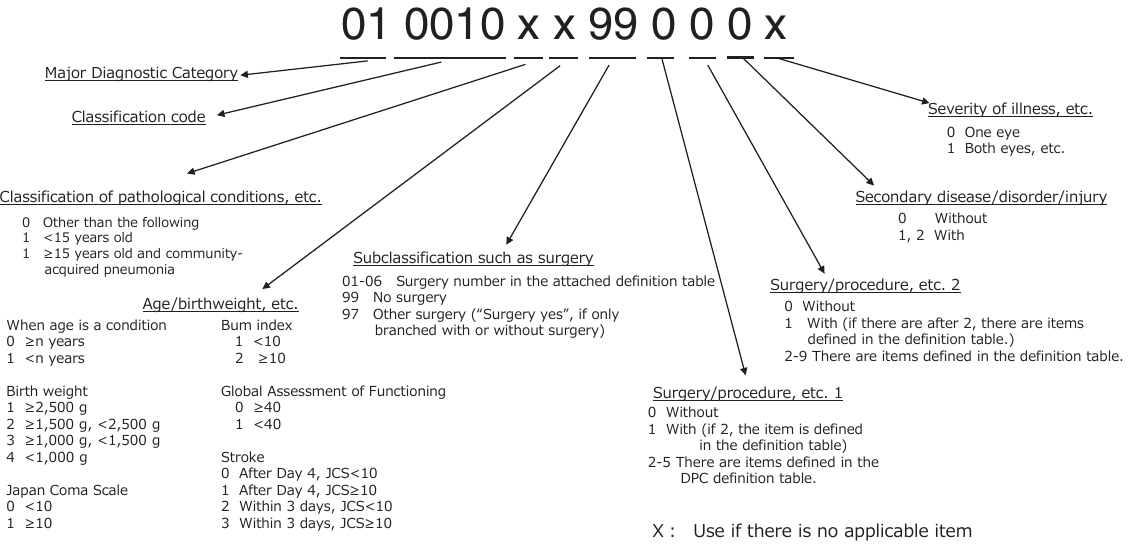
Figure 1. Structure of Diagnosis Procedure Combination codes (as of 2020) Table 1. Major Diagnostic Categories (MDCs)